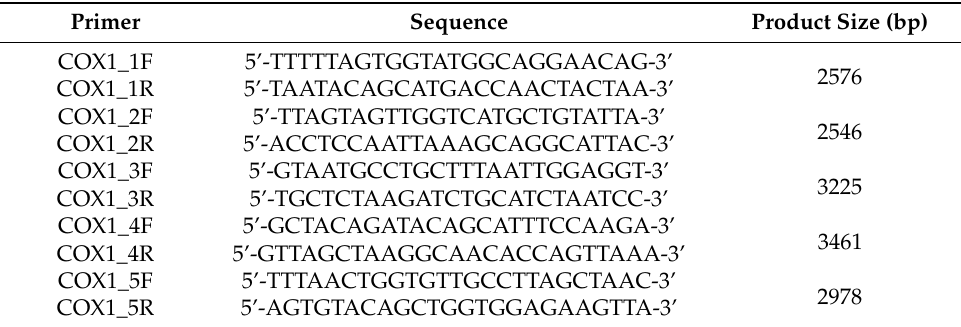
Table 1. PCR primers targeting the COX1 gene